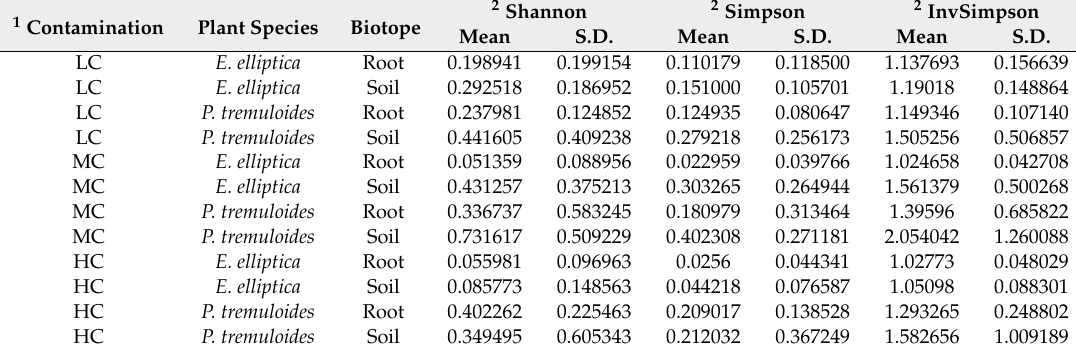
Figure 1. Box plot of observed Glomeromycota OTU richness associated with P. tremuloides and E. elliptica from decantation basins with lowest (LC), intermediate (MC) and highest (HC) petroleum hydrocarbon contamination. Welch’s ANOVA followed by the Games–Howell post hoc test showed no significant difference among three basins. Table 1. Alpha-diversity of arbuscular mycorrhizal fungi with regards to the host plant species identity and hydrocarbon contamination level in decantation basins from a former petrochemical plant. Mean and standard deviation (S.D.) were calculated from three replicates ( n = 3).